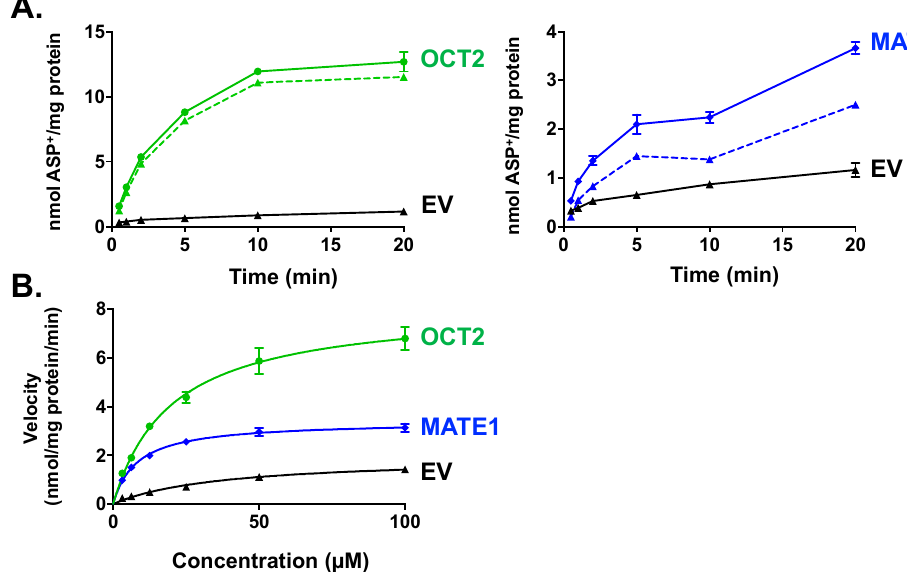
Figure 2. Time and Concentration-Dependent Accumulation of ASP + in HEK293 Cells Overexpressing OCT2 or MATE1. HEK cells expressing empty vector (EV), OCT2, or MATE1 were incubated for different time periods (0.5–20 min, 10 µ M ASP + , 37 ◦ C) to evaluate time-dependent uptake ( A ) or with increasing concentrations of ASP + (0–100 µ M, 1 min 37 ◦ C) for concentration-dependent uptake ( B ) on a shaker. Specific transport uptake is shown in dashed lines. Intracellular fluorescence was quantified and normalized to protein concentration. Data are presented as mean ± SE ( n = 3). Table 1. 5-HT 3 antagonist inhibition of in vitro ASP + transport by OCT2 and MATE1 in HEK293 cells 1 .